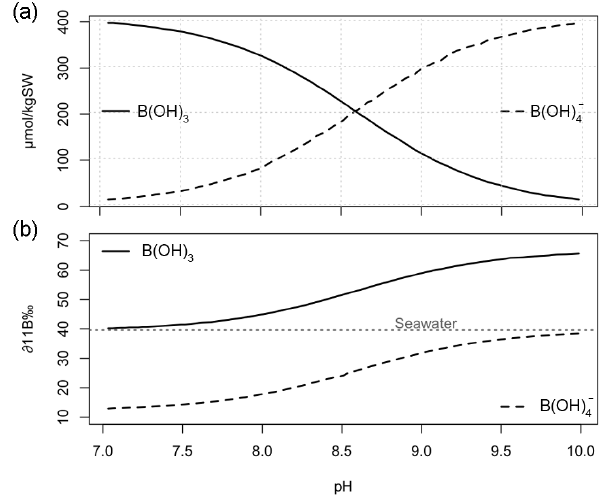
Figure 1. (a) Bjerrum plot showing the effect of pH on concentra- tion of dissolved boron species at T = 25 ◦ C, S = 35 and [B] total 416µmolkg − 1 . (b) Effect of pH on boron isotopic composition of B(OH) − and B(OH) 3 with thermodynamic fractionation factor 4 ( α 3 − 4 ) = 1 . 0272 (Klochko et al.,